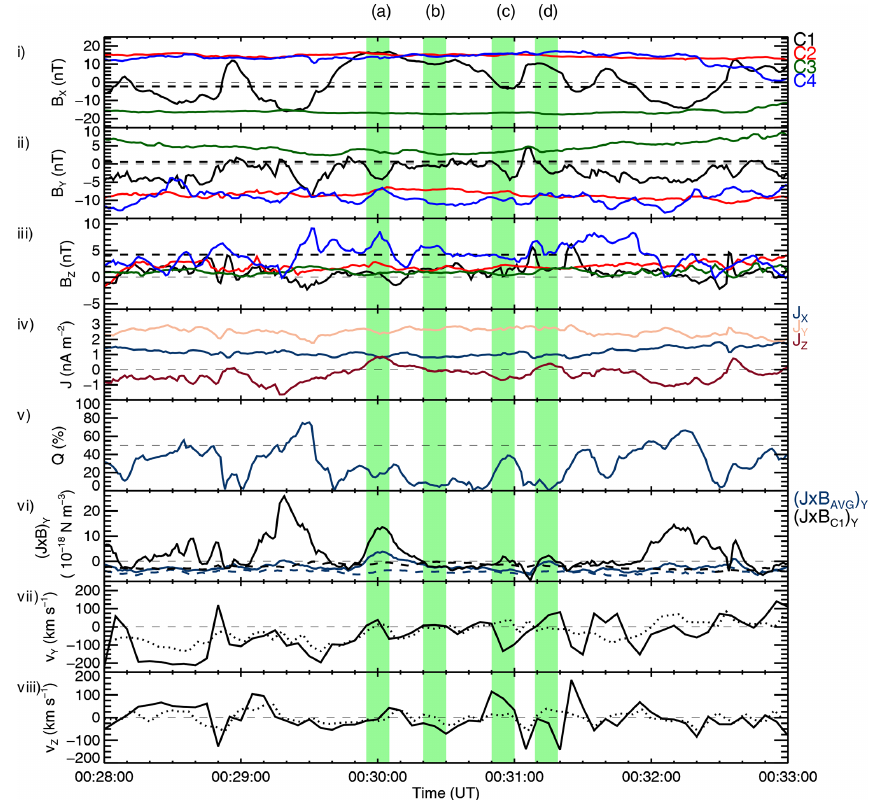
Figure 6. (i–iii) The local magnetic field vector B ( B x , B y , B z ) observed by C1–C4, as shown previously (solid lines), and the TA15 modelled B vector for C1 (dashed black lines). (iv) The components of the current density vector J ( J x , J y , J z ), (v) Q , (vi) ( J × B AVG ) y (solid blue line) and ( J × B C1 ) y (solid black line). The dashed blue and black lines indicate the equivalent calculation where the TA15 model B field of C1 has been used (see the text). (vii) v y ( v ⊥ y in solid lines), observed by C1, and (viii) v z ( v ⊥ z in solid lines), also observed by C1. The green highlighted regions labelled (a–d) correspond to four specific time windows of interest (discussed in the